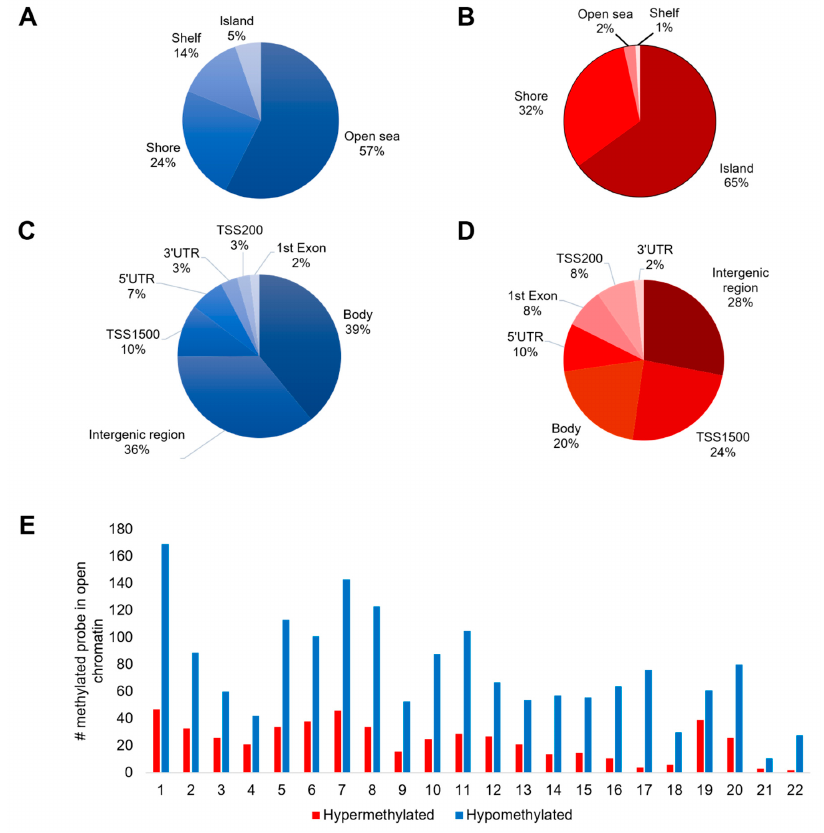
Figure 1. Differentially methylated open chromatins in CRC. ( A ) Distribution of hypomethylated open chromatins with respect to CGI features. ( B ) Distribution of hypermethylated open chromatins with respect to CGI features. ( C ) Distribution of hypomethylated open chromatins with respect to genomic regions. ( D ) Distribution of hypermethylated open chromatins with respect to genomic regions. ( E ) Chromosome-wise distribution of hypo- and hypermethylated open chromatins.